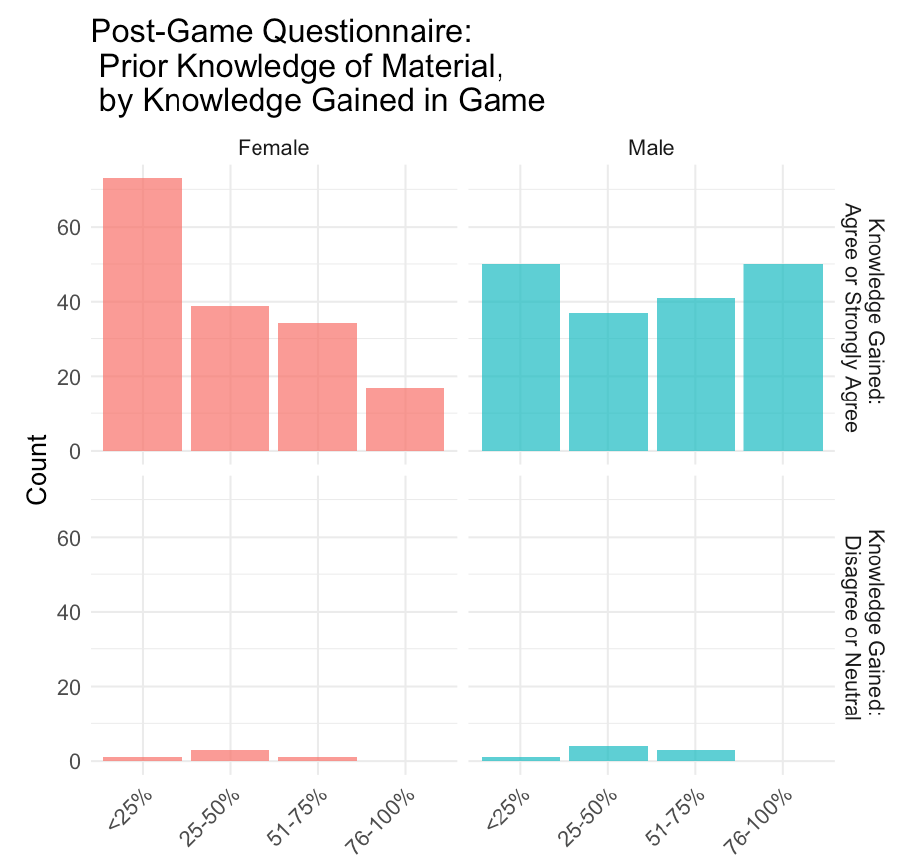
Figure 8. Perception of knowledge gained in game, by perception of knowledge already acquired.